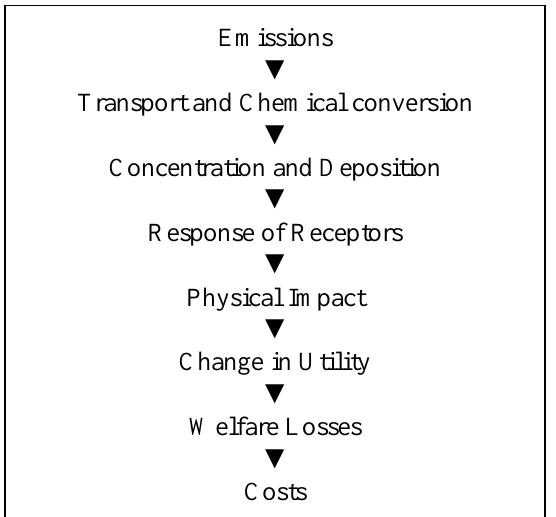
Figure 1. The impact pathway